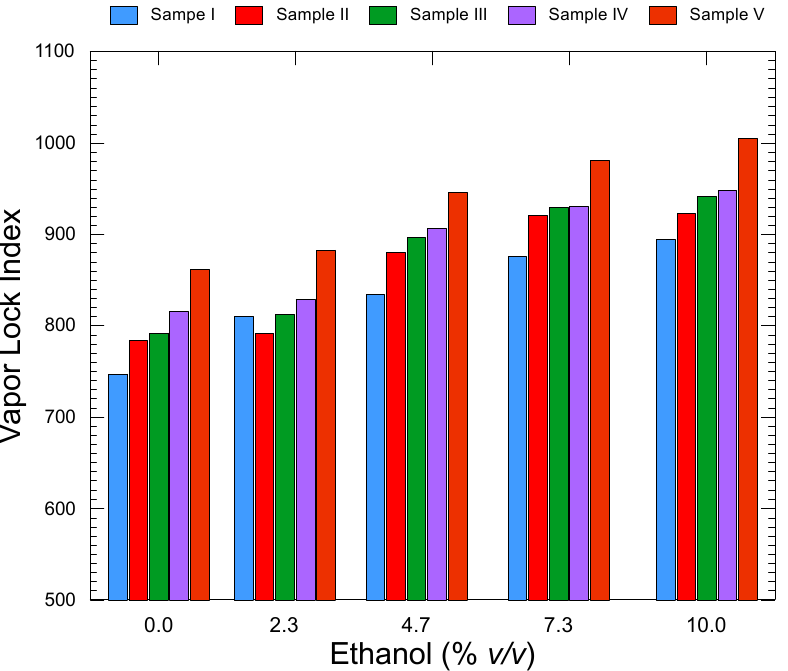
Figure 12. Vapor lock index (VLI) values for all of the blends against bio-ethanol content.